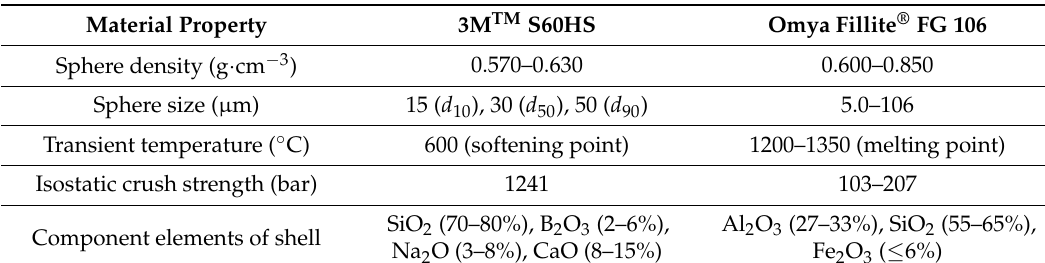
Table 1. Properties of 3M TM S60HS glass microspheres ([35] and direct information of 3M) and Omya Fillite ® 106 cenospheres [36].